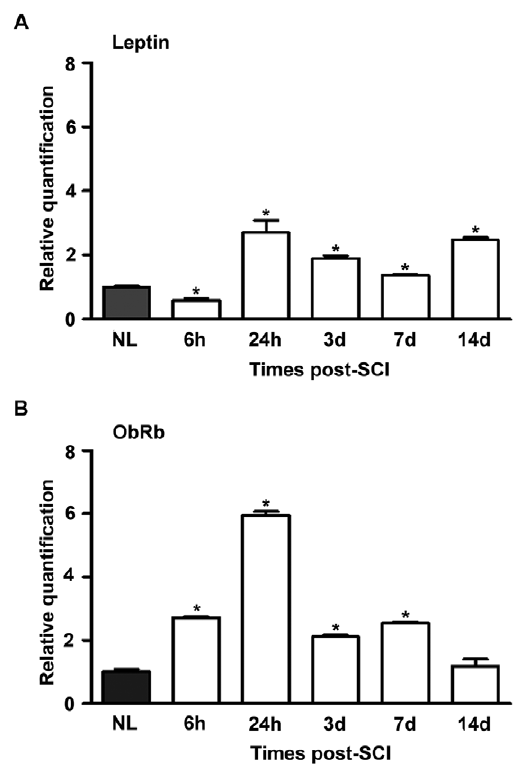
Figure 1. Leptin and ObRb are up-regulated after SCI. The expression of leptin (A) and ObRb (B) was quantified by RT-qPCR using specific primers (Table 1). The mRNA expression of ObRb was significantly increased 6 h post-SCI, while the mRNA expression of leptin was decreased. At 24 h, 3 d and 7 d post-SCI, the expression of both mRNAs was significantly increased. At 14 d post-SCI, leptin mRNA expression remained up-regulated, while ObRb mRNA expression had returned to the basal levels observed in the non-lesioned group (NL). Differences were calculated by setting the expression values of the NL samples at 1 and normalising against ribosomal 18S rRNA. The differences are shown as the mean 6 SEM; * p , 0.05 versus NL.